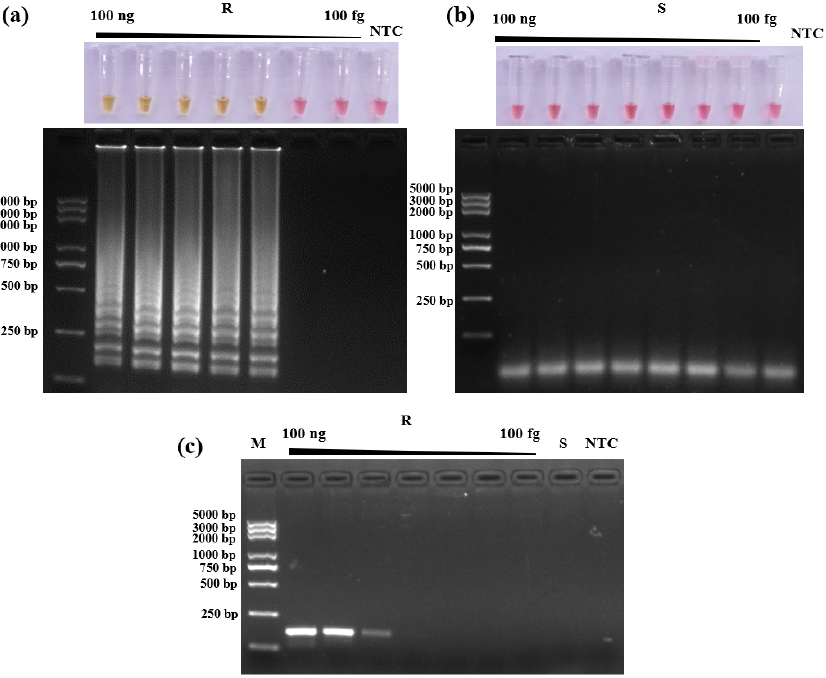
Figure 5. Sensitivity test of the LAMP reaction ( a , b ) and conventional PCR ( c ) for G143A in Corynespora cassiicola . LAMP reaction products of pyraclostrobin-resistant isolate ( a ) and -sensitive isolate ( b ) were evaluated on the basis of color change (upper) and corresponding gel electrophoresis detection (lower); conventional PCR products were assessed by 2% gel electrophoresis ( c ). The template genomic DNA concentrations used in reaction tubes from left to right were 100 ng, 10ng, 1 ng, 0.1 ng, 0.01 ng, 0.001 ng, and 100 fg. “S”, pyraclostrobin-sensitive C . cassiicola isolate Cc4; “R”, pyraclostrobin- resistant C . cassiicola isolate Cc66. “NTC”, negative treatment control with dH 2 O as reaction template.